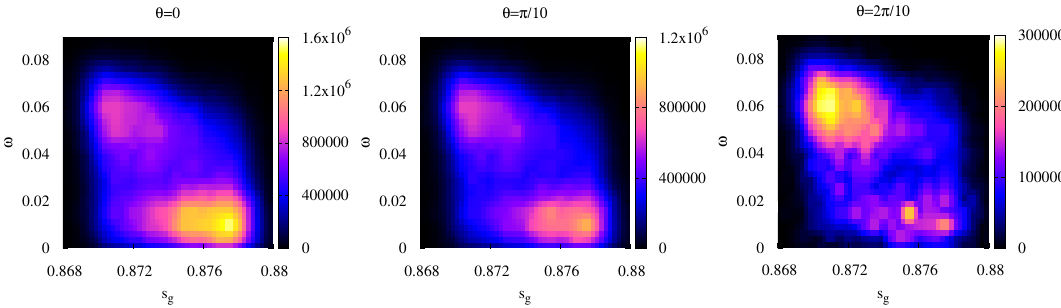
Figure 6 . The numerator of the integrand in (2.12) for θ = 0 , π/ 10 and 2 π/ 10 from left to right.